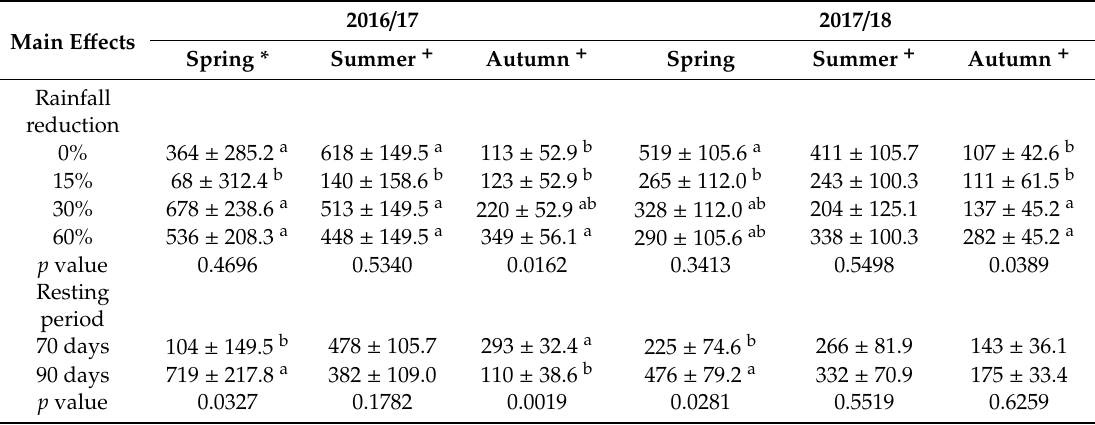
Table 4. Main e ff ect of resting period and rainfall reduction on forbs (mean ± S.E) aboveground biomass yield (kg.ha − 1 ).